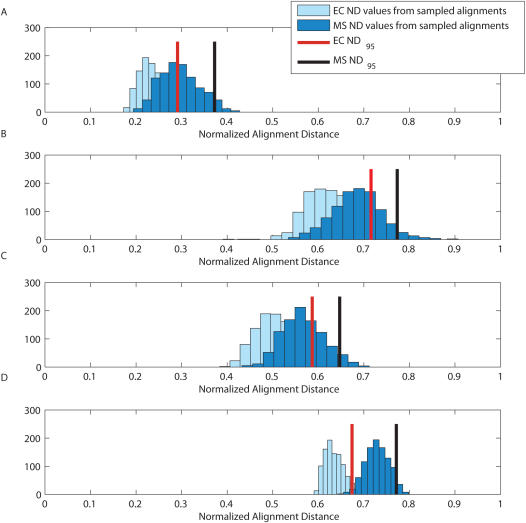
Histograms of the distances of the sampled alignments from the EC and MS.In (A) the centroid and optimal alignments are similar and represent the distribution well, but in (B) and (C), despite a similar centroid and optimal alignment, neither represent the overall alignment distribution. In (D) it is observed that the centroid and optimal deviate significantly from each other, and that the centroid is a much better representation of the alignment space.